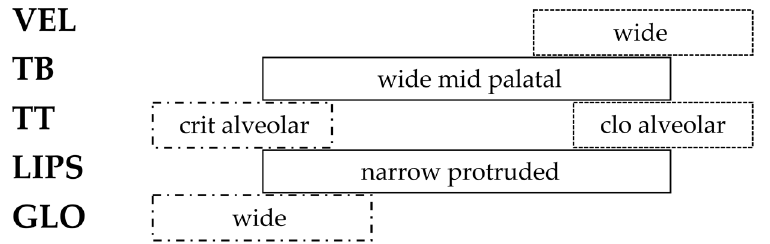
Figure 2. Gestural score for the word [sœn] ‘son’ in Danish.